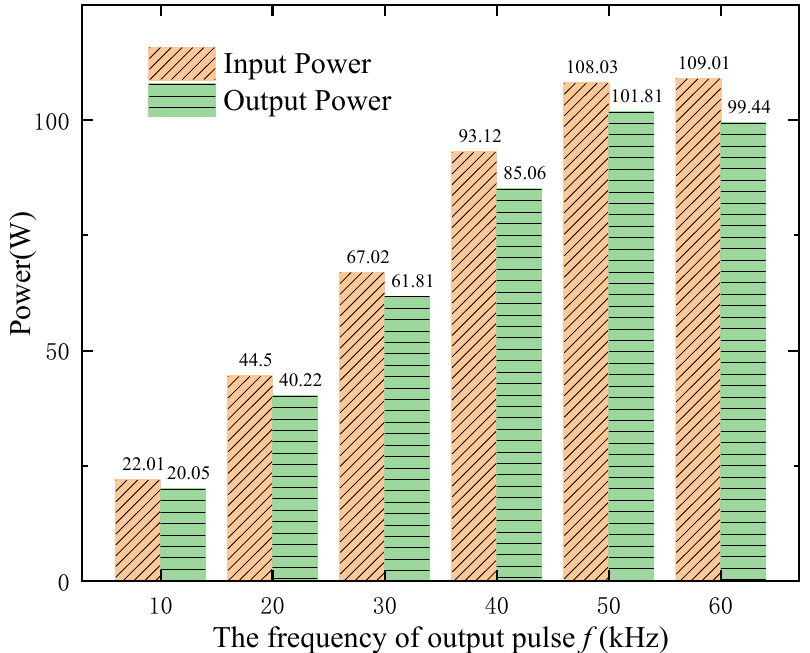
Figure 13. The power with a different output pulse frequency.